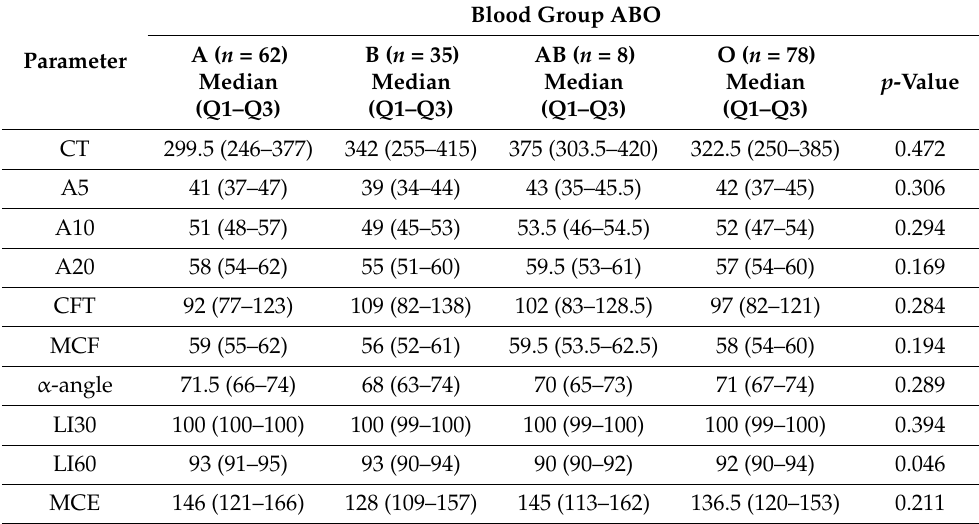
Table 5. NATEM parameters and blood group of